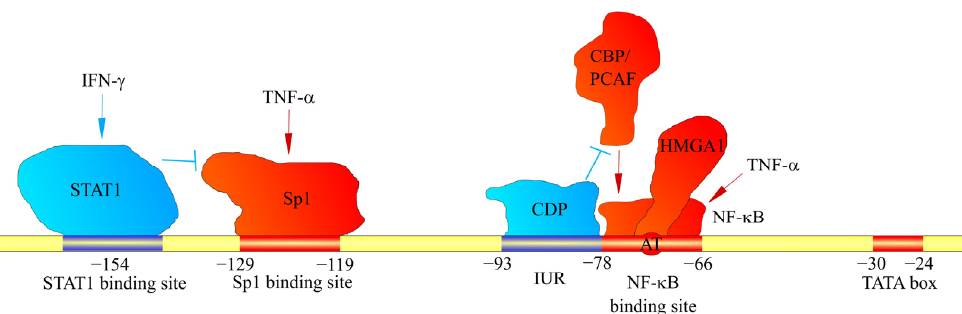
Figure 1. Factors affecting CXCL1 gene transcription. The CXCL1 promoter contains binding sites for factors that bind to these sites. They either increase (shown in red) or decrease (shown in blue) CXCL1 expression. In particular, the CXCL1 promoter contains a binding site for STAT1 and Sp1. STAT1 and Sp1 activated by IFN- γ and TNF- α , respectively, attach to these sites. Sp1 increases CXCL1 expression; however, STAT1 inhibits Sp1 binding to the CXCL1 promoter. Another mechanism regulating CXCL1 expression is IUR, a region that directly borders the NF- κ B binding site. CDP binds to IUR, which inhibits the recruitment of CBP and PCAF coactivators by NF- κ B. This prevents the induction of CXCL1 expression by NF- κ B.